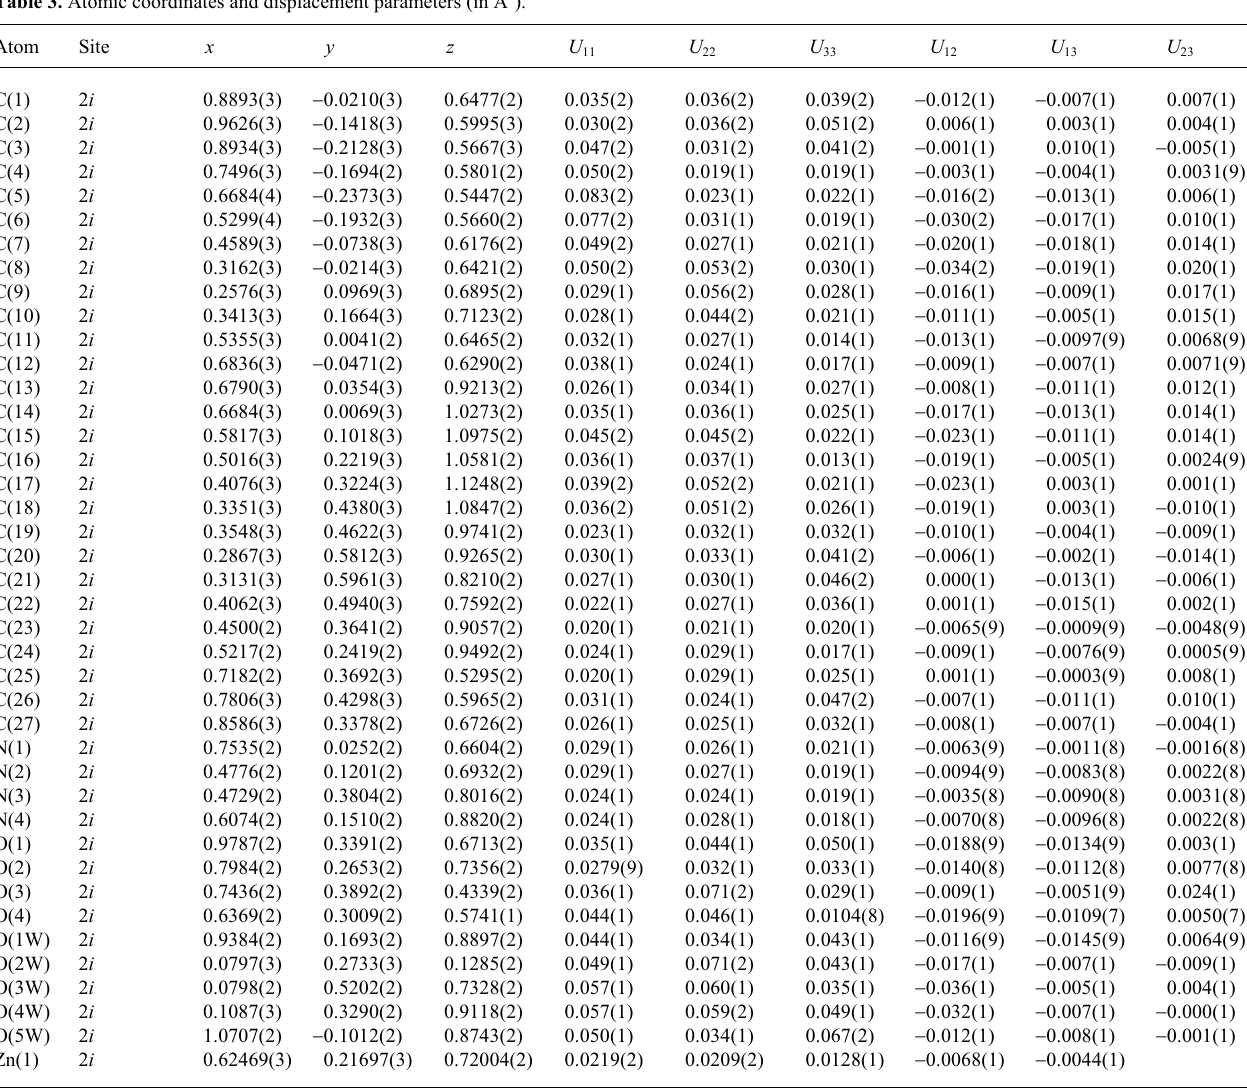
Table 3. Atomic coordinates and displacement parameters (in Å 2